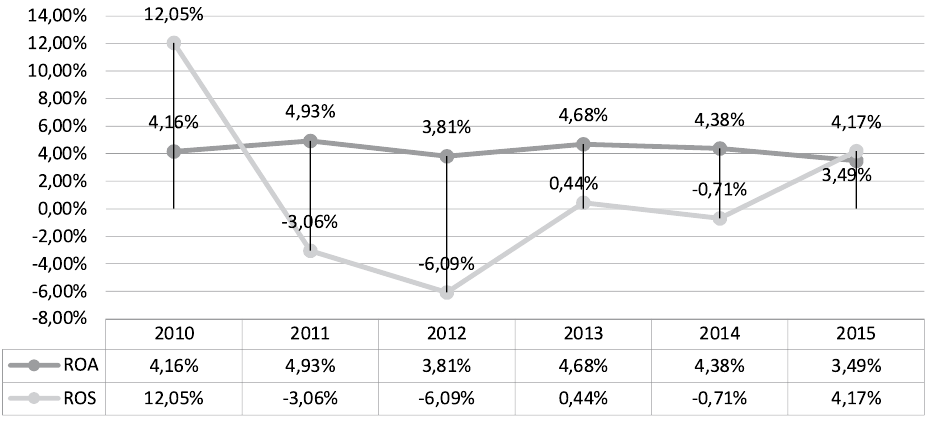
Figure 1. ROA & ROS: Companies Presented on Foreign